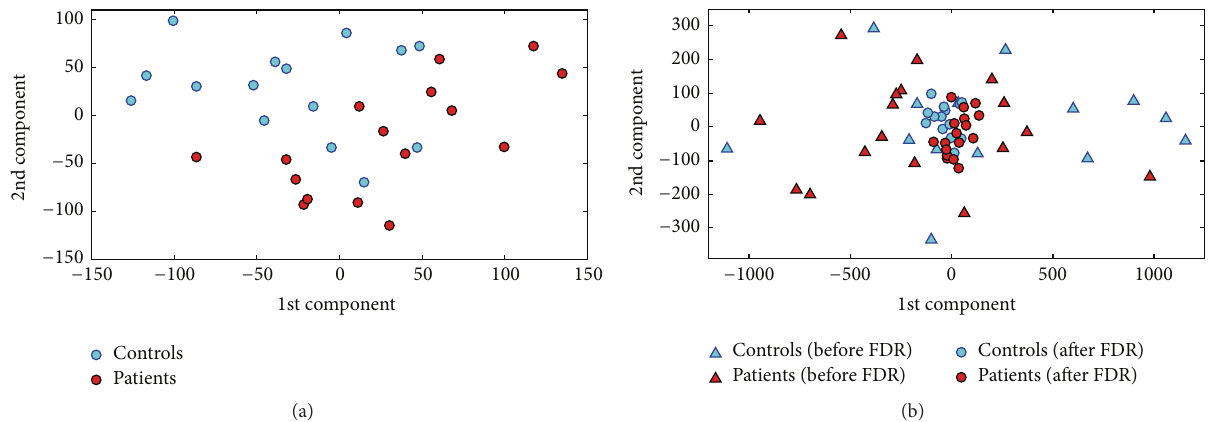
Figure 1: Plot of the PCA coefficients that showed the highest FDR (a) and joint plot of the PCA coefficients before (triangles) and after (circles) FDR ranking (b) for the ED versus HC group discrimination (1st and 2nd components). Data from a single round of CV are shown as a representative example.